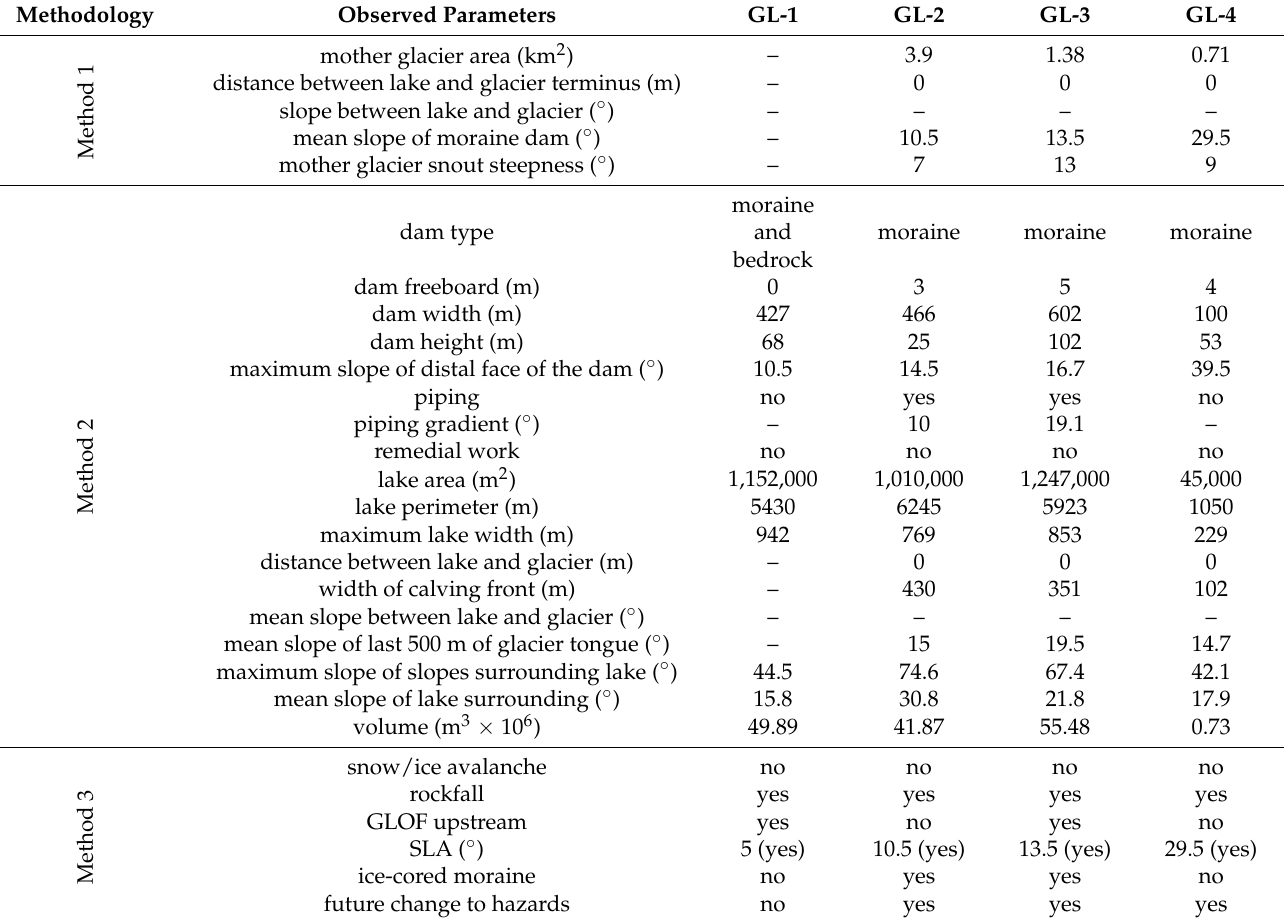
Table 6. Results of observed parameters of each method used in GLOF hazard assessment.